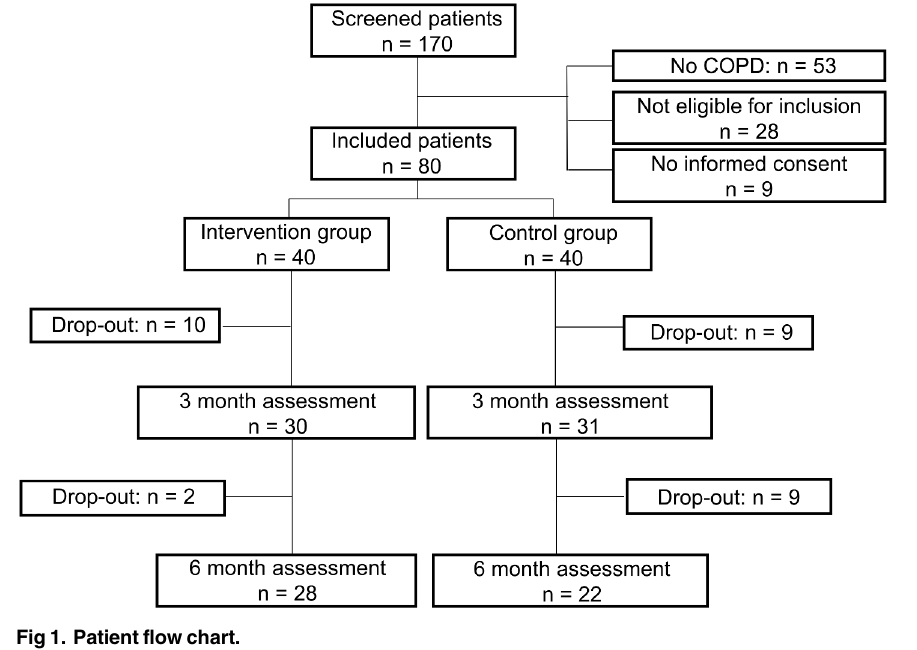
Fig 1. Patient flow chart.